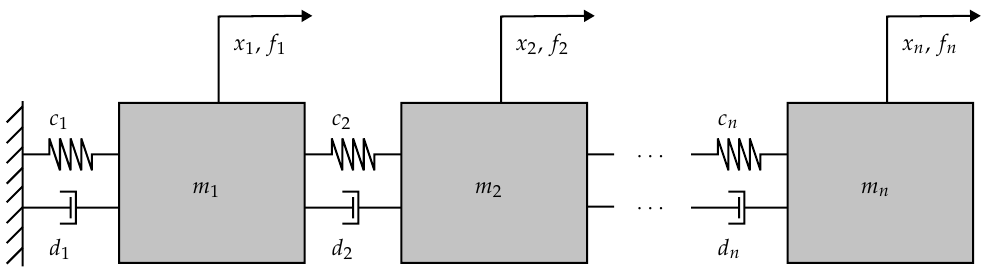
Figure 4. Schematic illustration of an MDOF system used for generating synthetic measurement data in Section